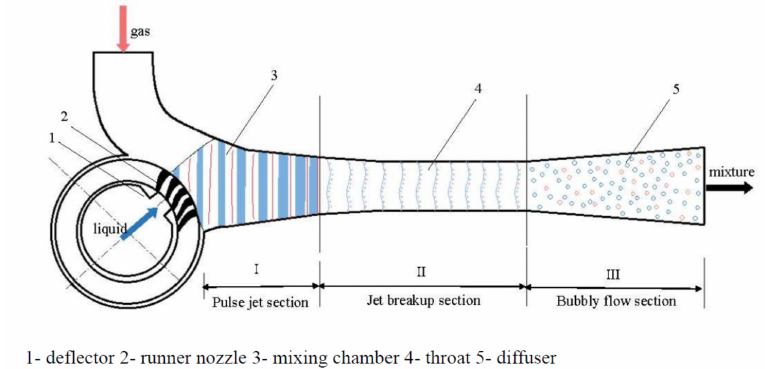
Figure 2. Working principle and structure diagram of the